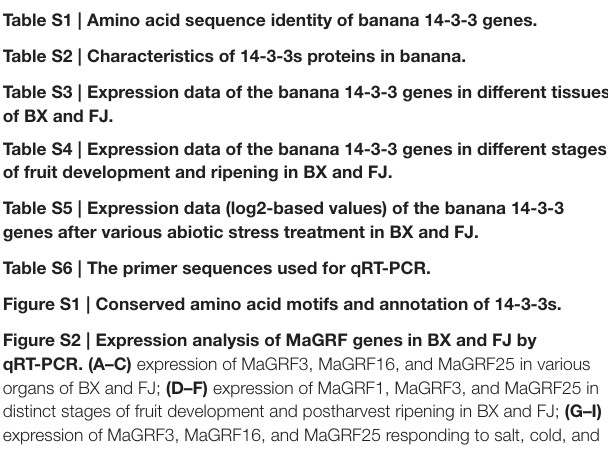
Table S1 | Amino acid sequence identity of banana 14-3-3 genes. Table S2 | Characteristics of 14-3-3s proteins in banana.